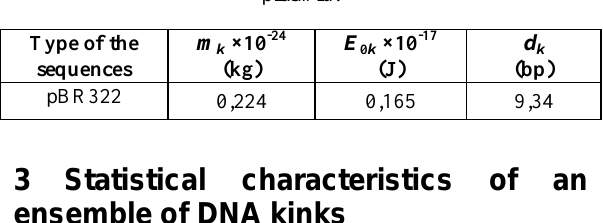
Table 3 . Dynamic parameters of the kinks activated in